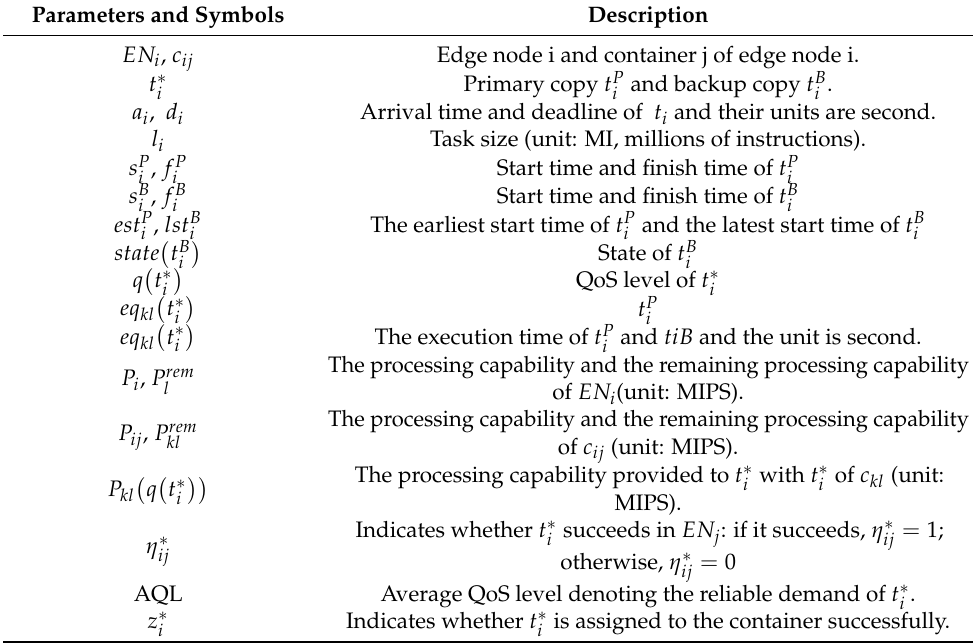
Table 1. Parameters and symbols.